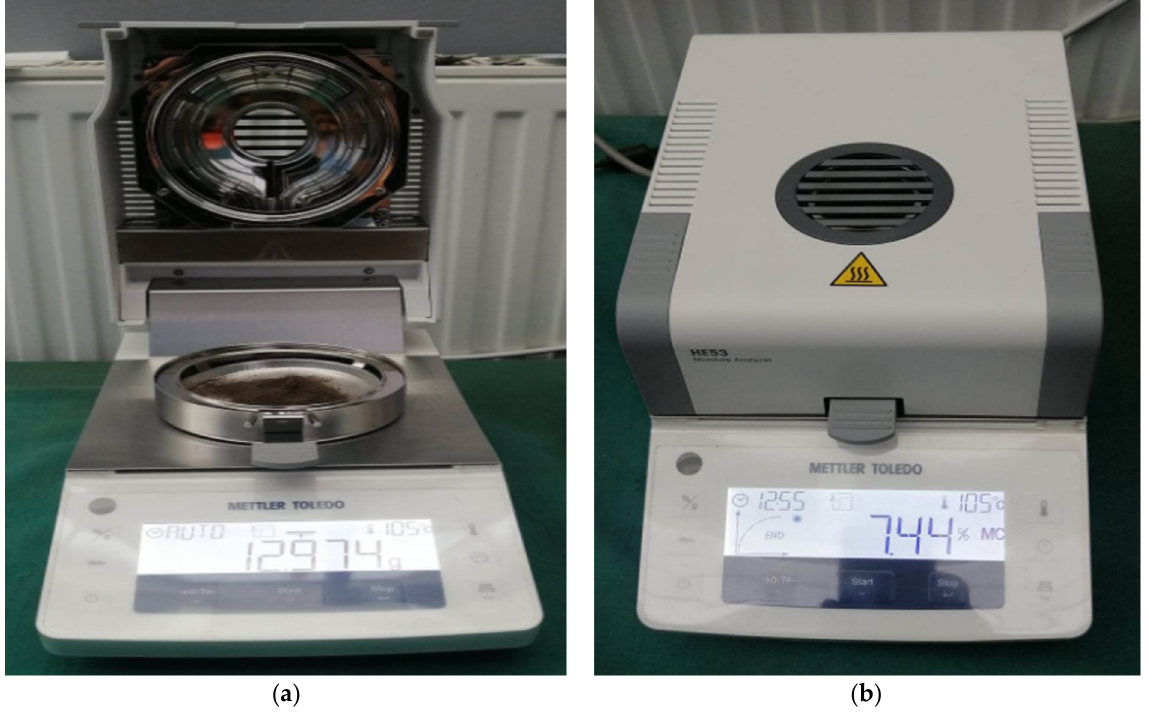
Figure 2. The moisture analyzer (HE53 230 V) showing the ( a ) mass of a sample and ( b ) percentage of moisture content.